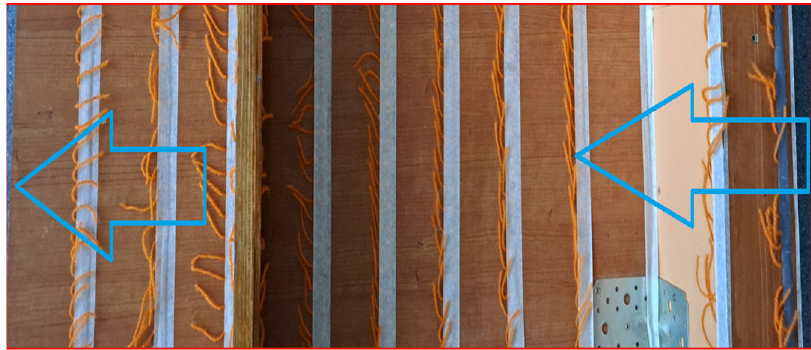
Figure 8. The wool wires mounted on the model showing the reverse flow.